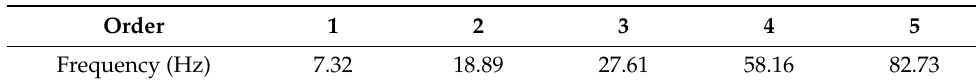
Table 2. Natural frequency of the WTB.